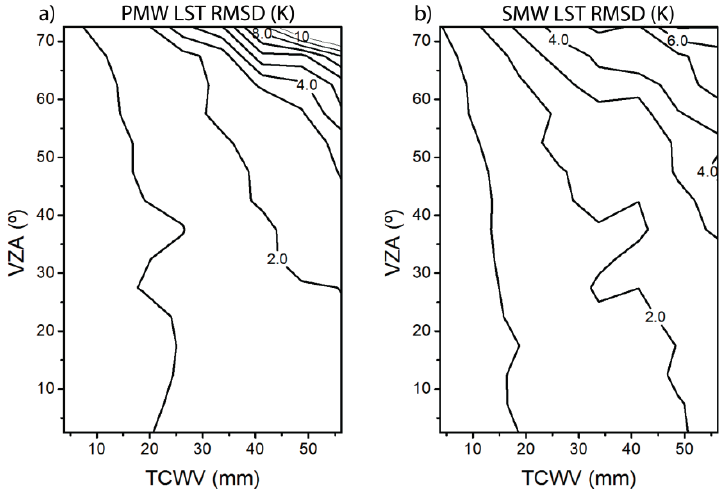
Figure 2. Theoretical uncertainty for MSG/SEVIRI LST estimates. ( a ) Physical radiative transfer-based mono-window model (PMW); ( b ) statistical mono-window model (SMW). The values are the root mean square differences, assuming model and input uncertainties. VZA, satellite viewing